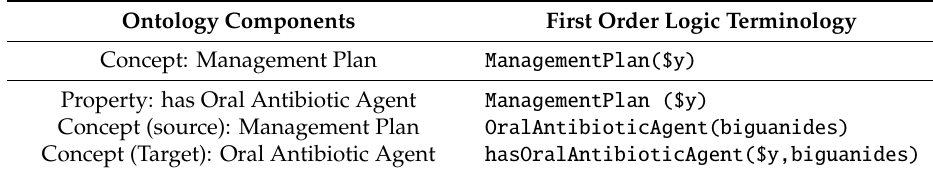
Table 3. First order logic